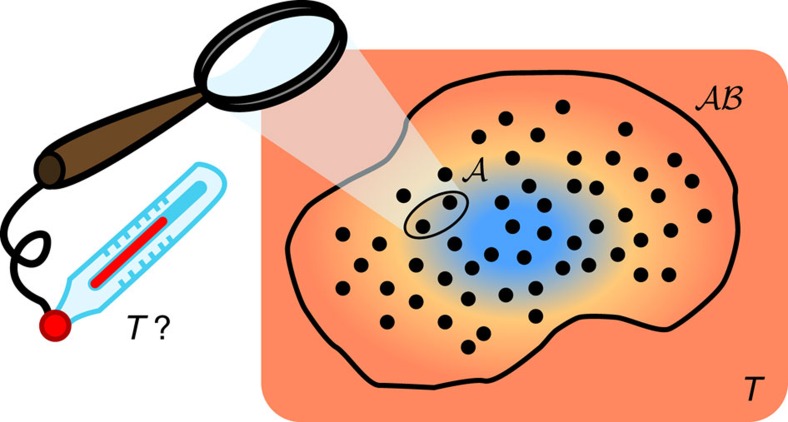
Temperature estimation via local measures.We propose the following operationally grounded strategy, which is embodied by the local quantum thermal susceptibility (LQTS) functional. A composite quantum system  is in thermal equilibrium with a bath at temperature T. The LQTS measures the highest achievable accuracy in the estimation of T under the hypothesis to perform only local measurements on a given subsystem  of .